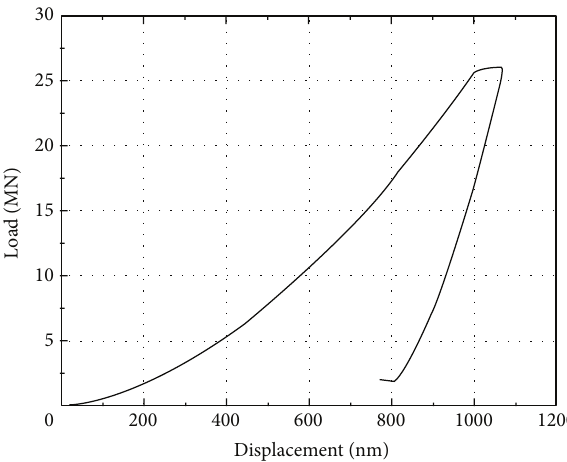
Figure 1: A representative load-displacement curve of nanoinden-